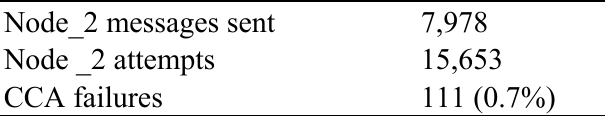
Table 2. CCA experimental